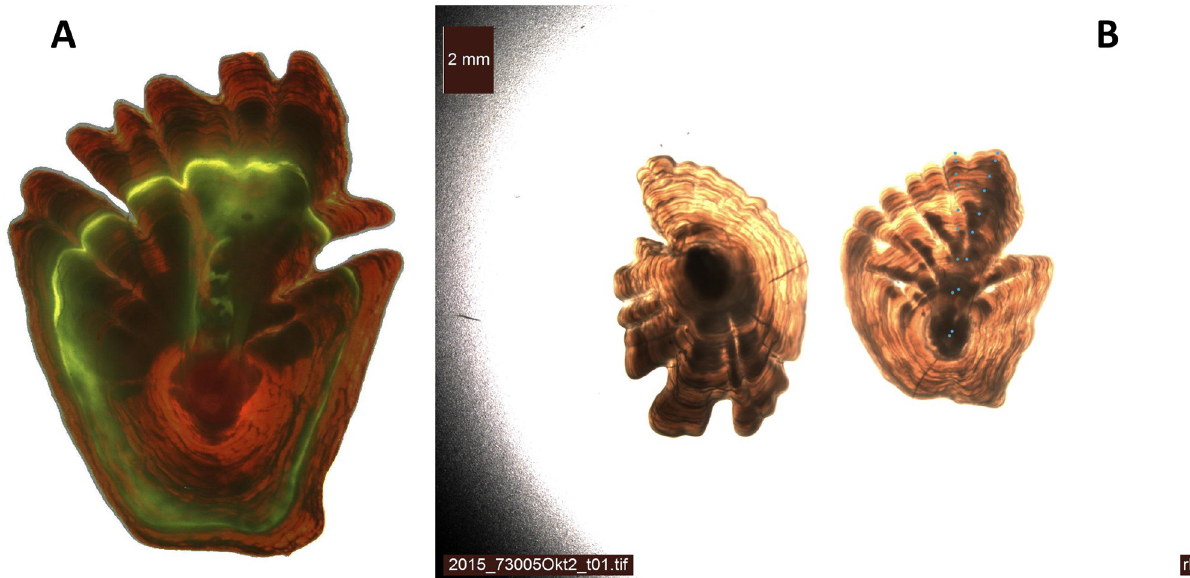
Fig 1. Greenland halibut otoliths. A: An example of a Greenland halibut otolith, where the otolith growth is revealed when recatching a fish that has previously been injected with OTC. B: Otoliths develop annual zones as the fish grows older. Back-light through the translucent Greenland halibut otolith reveals the otolith annual zones, which are counted to determine the age from the right otolith (two “parallel” dot series by two different readers).